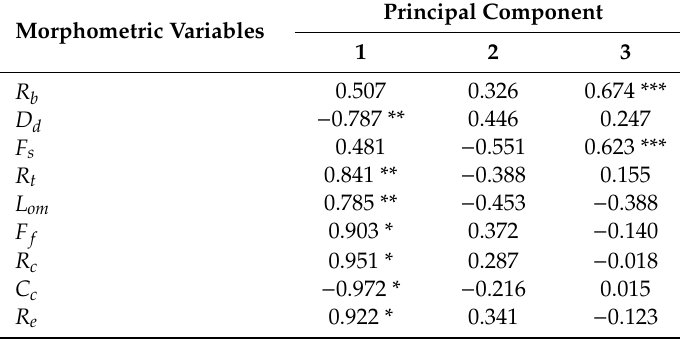
Table 9. Unrotated factor-loading matrix of morphometric variables.